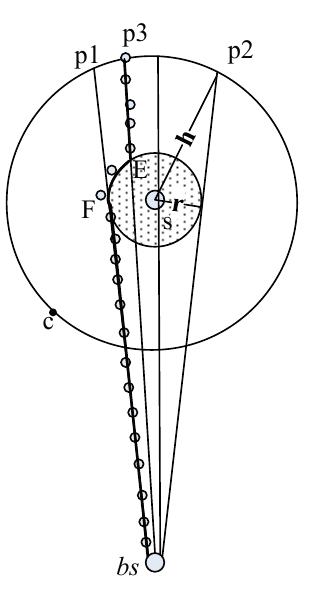
Figure 1. The shortest path bypassing the unsafe